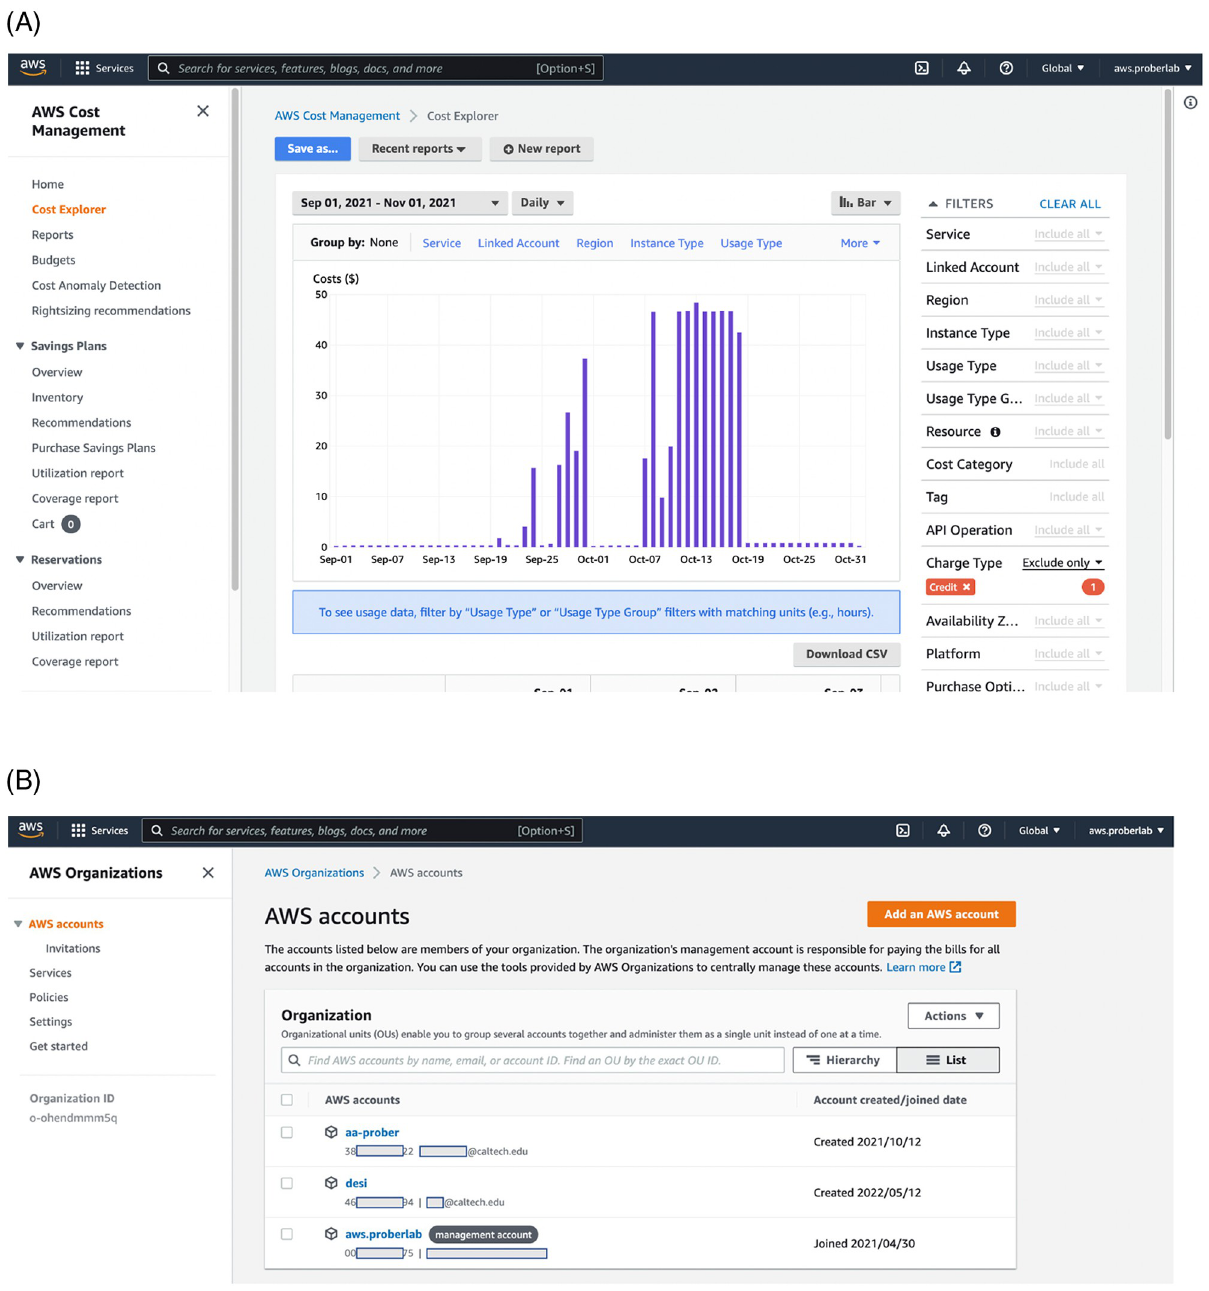
Fig 2. (Top) AWS Organizations portal lists all users and allows addition and creation of new users within the organization. Responsibility for billing of these users are fully on the organization. Creation of new users through Organizations interface is recommended because it allows easy removal of accounts after, for example, student leaves, or the project is finished. (Bottom) Billing Dashboard provides access to multiple tools to manage spending on the level of organization. One of the tools for control is the AWS Cost Management Cost Explorer console. Administrator can check spending by service type (for example, only computing or only storage) and by user